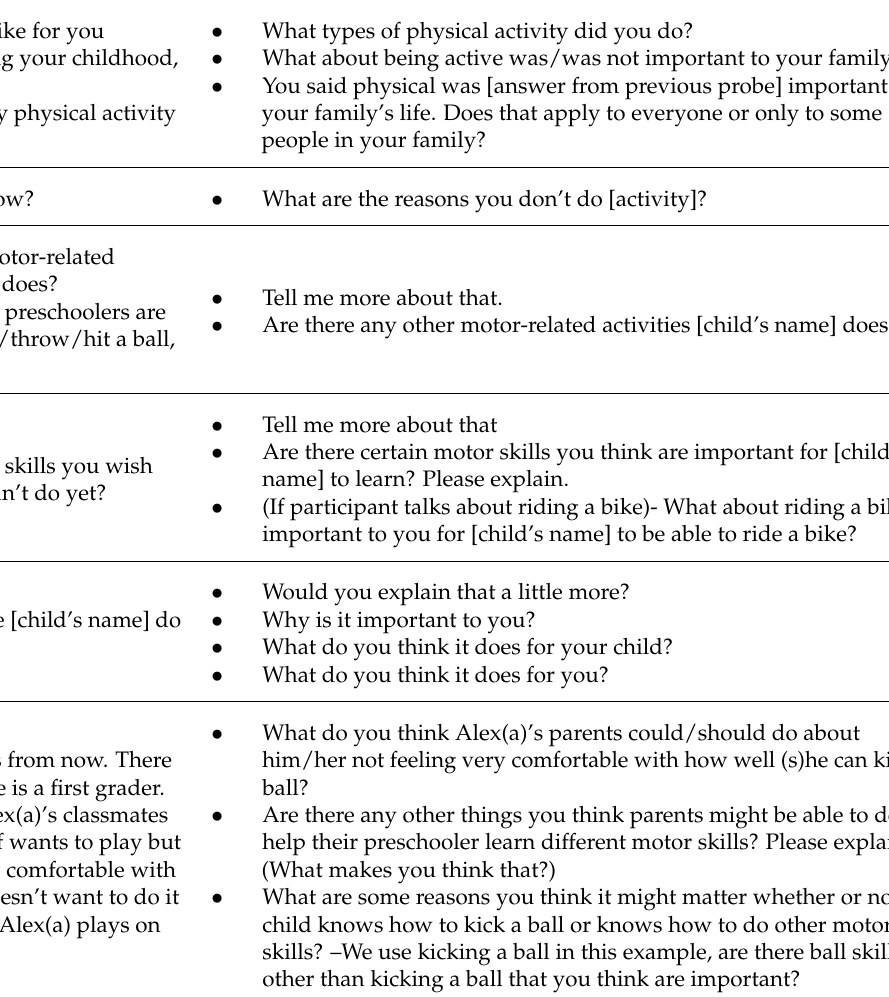
Table 1. Sample questions by construct asked in semi-structured, in-person interviews with parents of preschoolers about physical activity and fundamental motor skills.